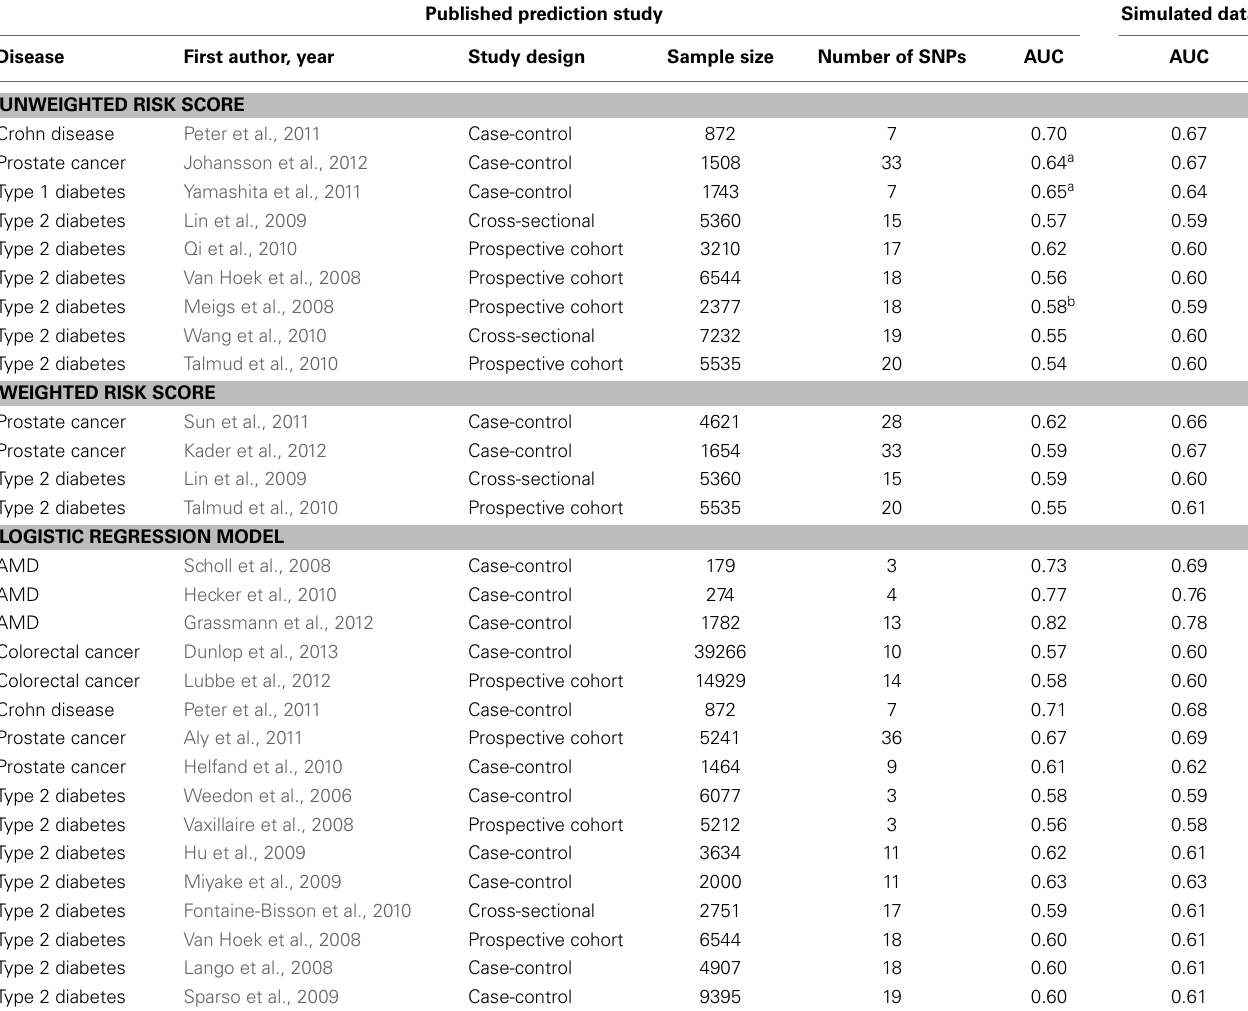
Table 1 | AUC values in published prediction studies and their estimates in simulated